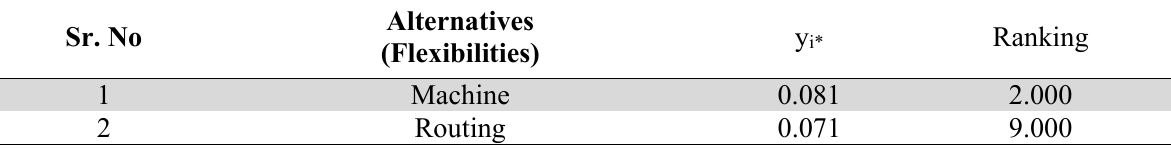
Ranking of flexibility (considering weights of attributes) Sr.